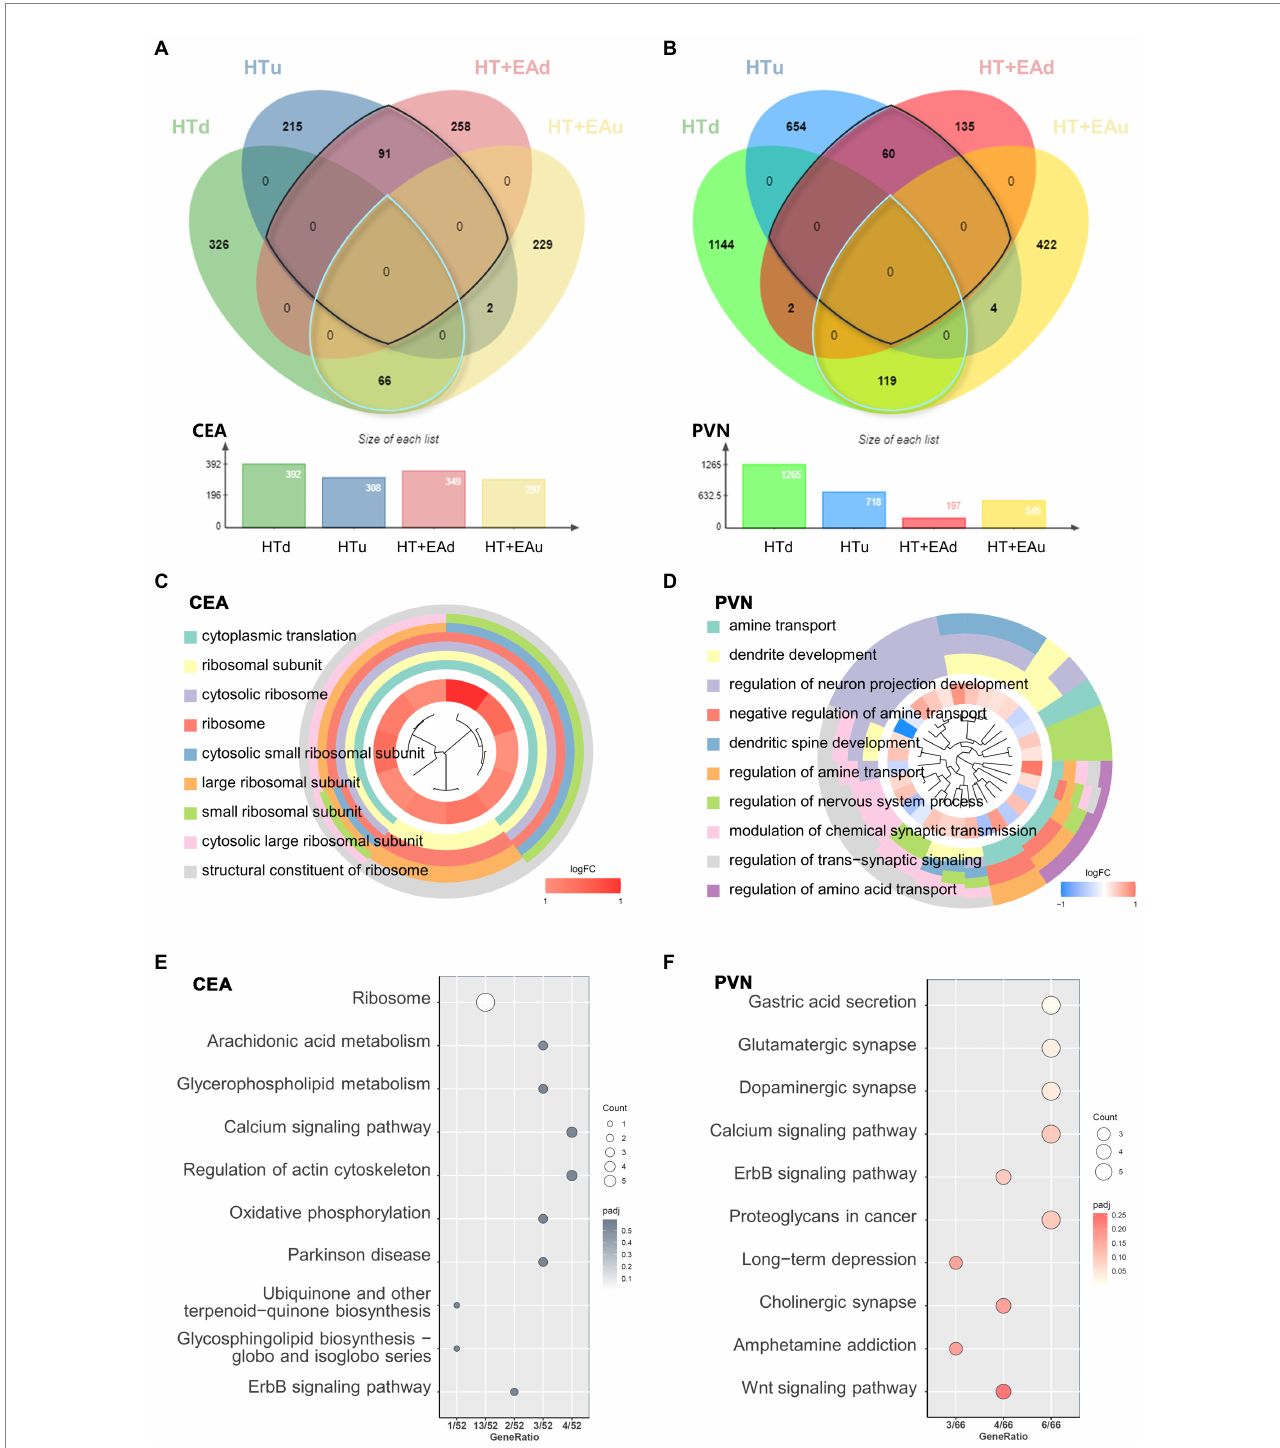
FIGURE 3 Transcriptional patterns and functional enrichment analysis. (A,B) Venn diagrams showing the overlap of DEmRNAs among the HTu, HTd, EAu, and EAd groups. (C,D) GO cluster and (E,F) KEGG pathway analysis of DEmRNAs in the CEA and